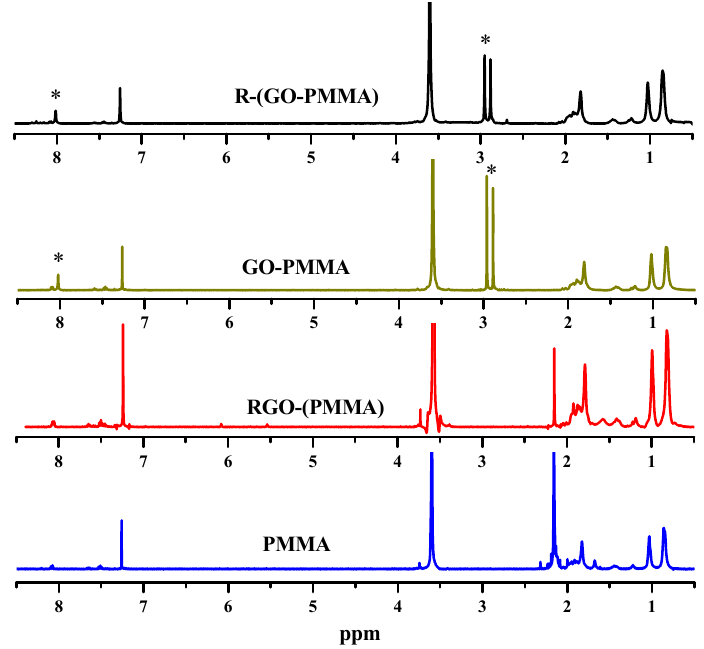
Figure 2. 1 H-NMR spectra of neat PMMA and all of the nanocomposites prepared from in situ bulk polymerization and MWI [* indicates residual solvent (DMF)